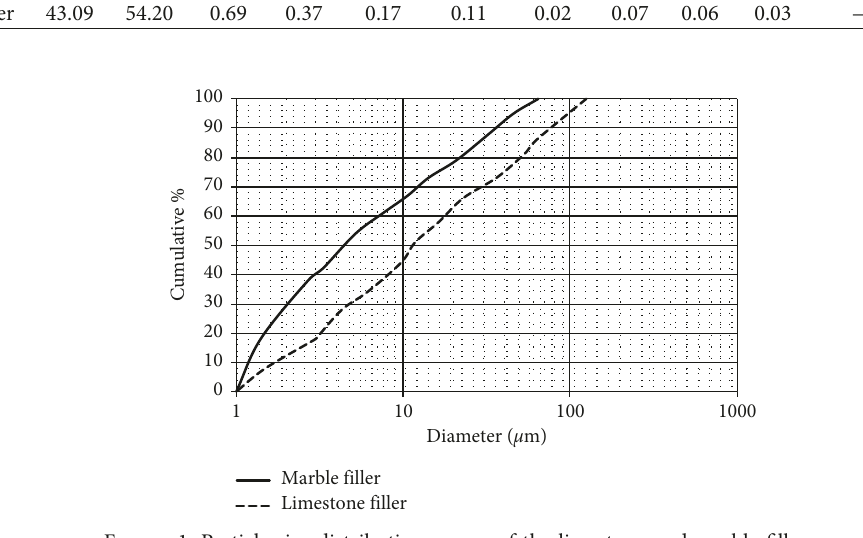
Figure 1: Particle size distribution curves of the limestone and marble fillers. Table 2: Physical parameters of two powders.